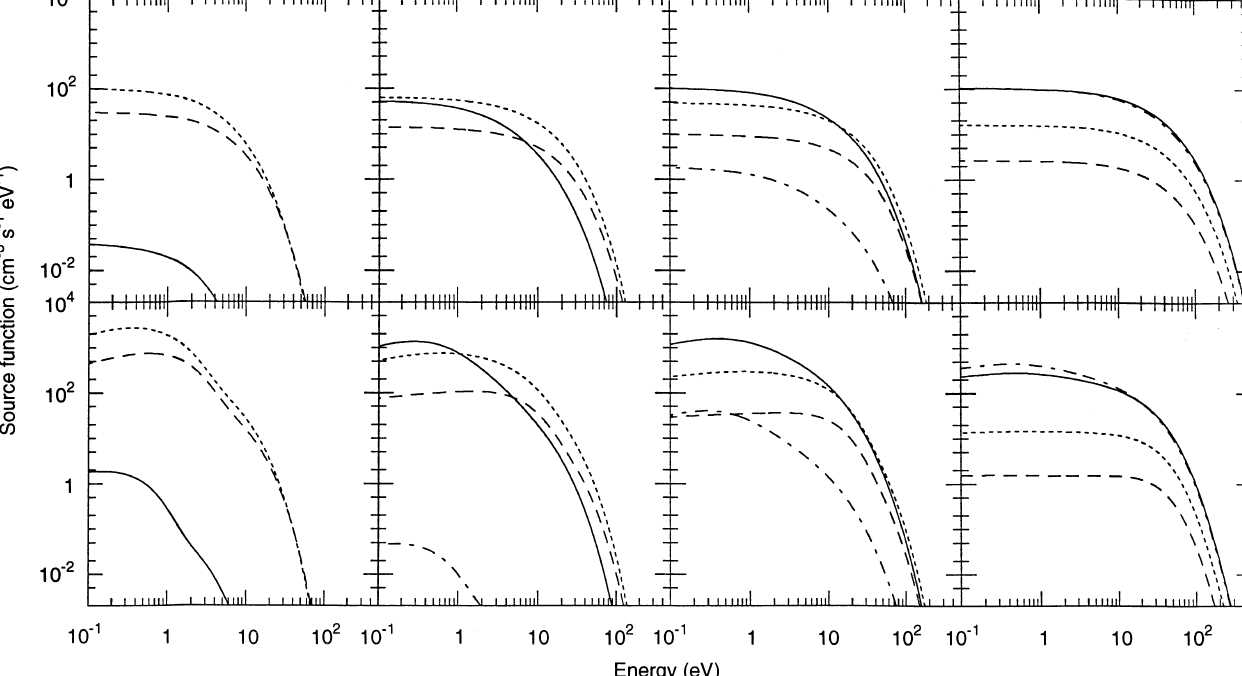
Fig. 5. The abscissa is the energy of the proto-electrons in eV. The ordinate is the proto-electron source function. In the four upper panels , the source functions are related to interactions between protons and ambient neutrals; in the four lower panels , they are related to collisions between H atoms and ambient neutrals. From left to right are the